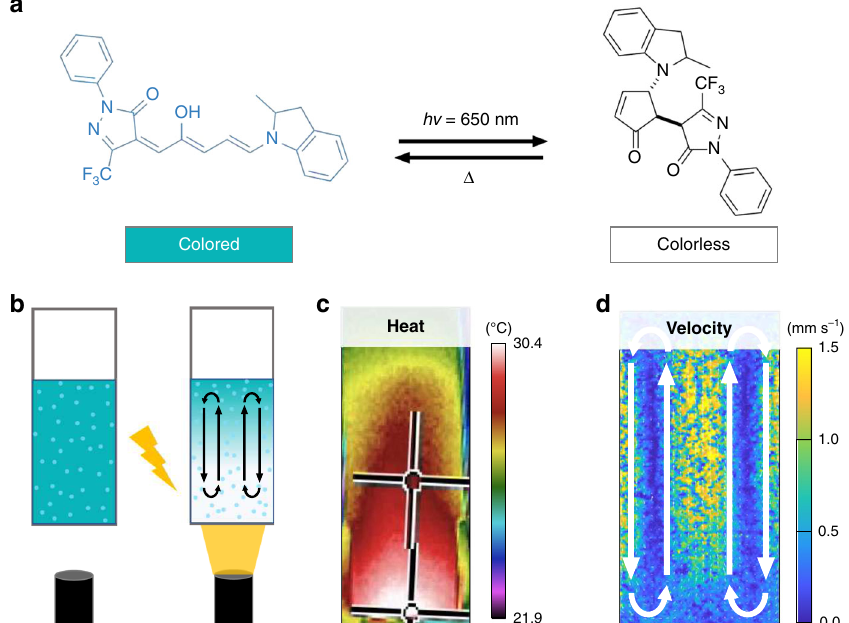
Fig. 1 Donor-acceptor Stenhouse adducts for photothermal control of fl uid fl ow. a DASA-CF 3 -PI switching under visible light irradiation from an extended, colored, open form to a compact, colorless, closed form. b Schematic of experimental setup for convective particle tracking. Light shone on the bottom of a quartz cuvette causes DASAs to switch to the colorless form, while also generating c heat gradients and d fl uid fl ows due to convection in toluene.